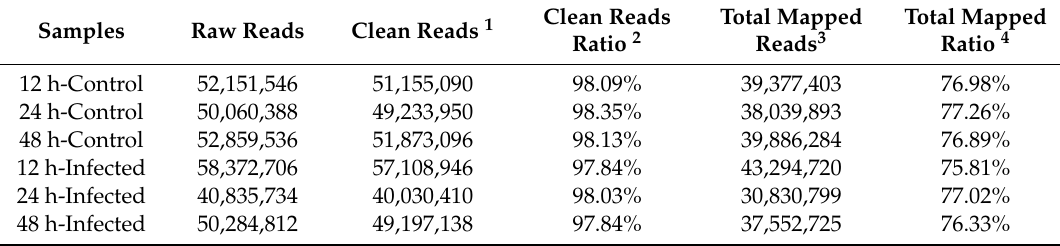
Figure 1. Duck Tembusu virus (DTMUV) RNA copies in The brain, liver, spleen, and kidney. DTMUV RNA copies were detected by absolute quantitative real-time PCR. Y-axis represents RNA copies in one microgram total RNA. * means p ≤ 0.05. Table 1. Statistics of sequencing